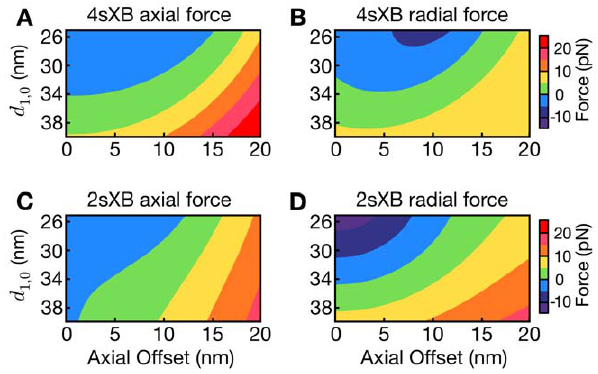
Figure 5. Axial and radial post-power stroke forces as separate components. (A)–(D) show, separated, the axial and radial compo- nents of the forces produced by the 4sXB and the 2sXB models in the post-power stroke state.